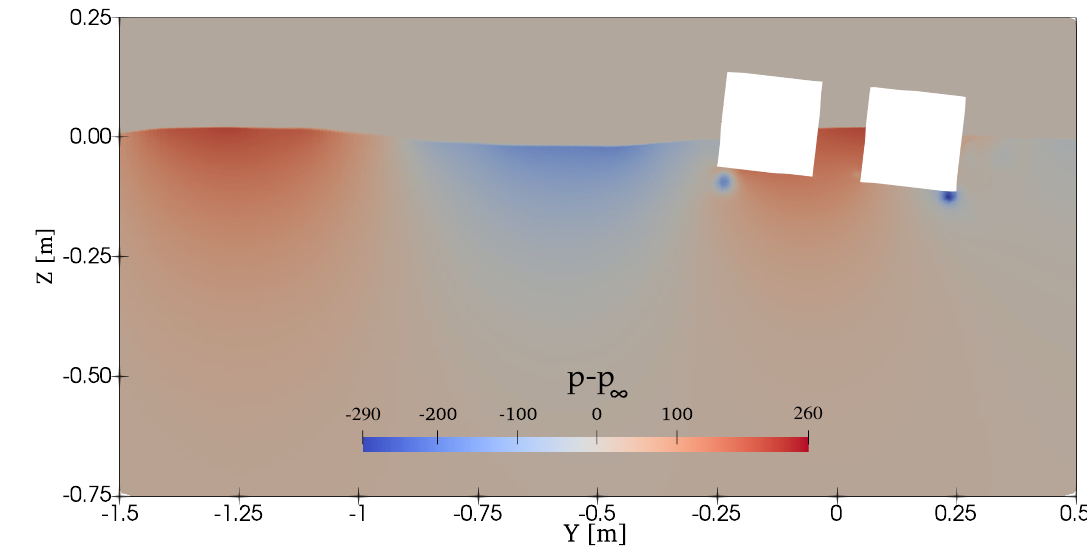
Figure 12. Pressure contours upstream of the moonpool-type structure. The wave steepness is H / λ = 1/30 and the period is T = 0.95